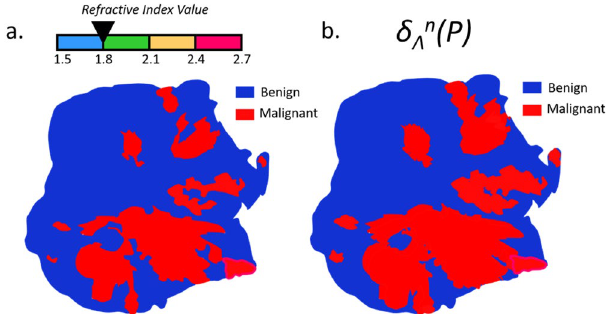
Figure 5. Schematic of a morphological dilation applied to a binary refractive index map over a tissue sample. ( a ) Binary refractive index map with a threshold set at 1.8; ( b ) morphological dilation applied to the binary n refractive index map with an arbitrary classifier (cid:31)